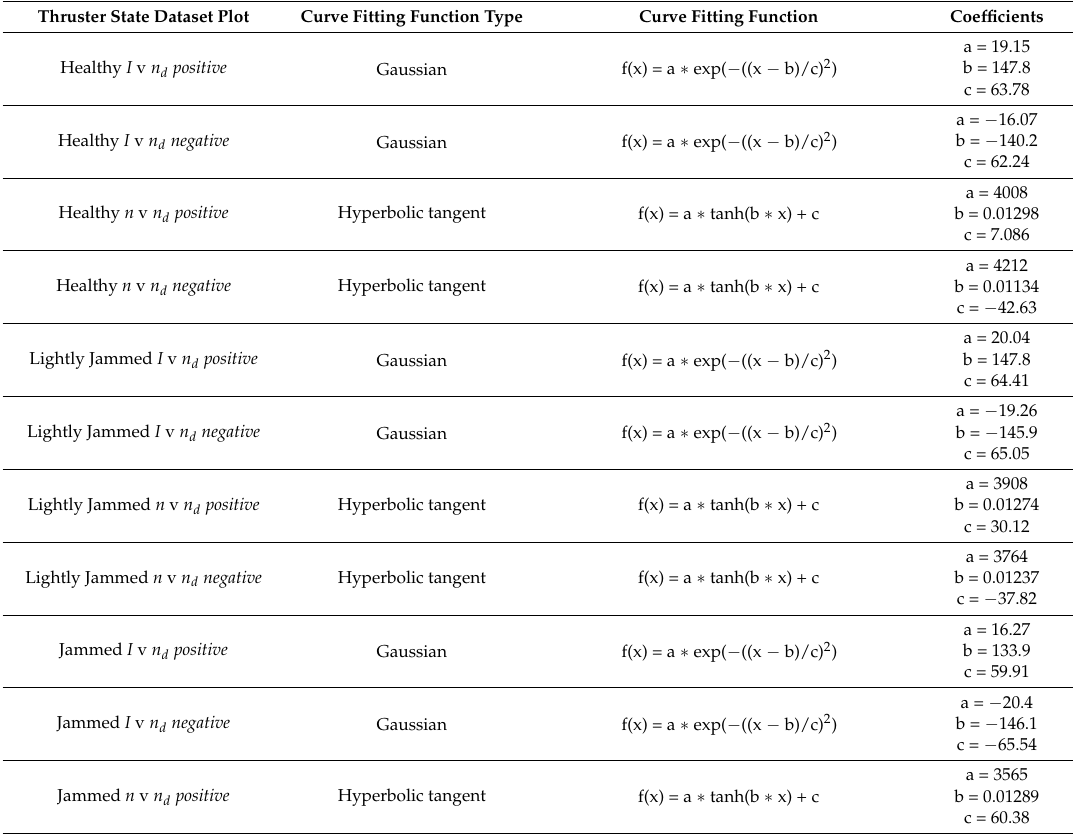
Figure 7. Diagrams of raw & best fit training data: n versus n d plot. Table 5. Curve Fitting functions for thruster